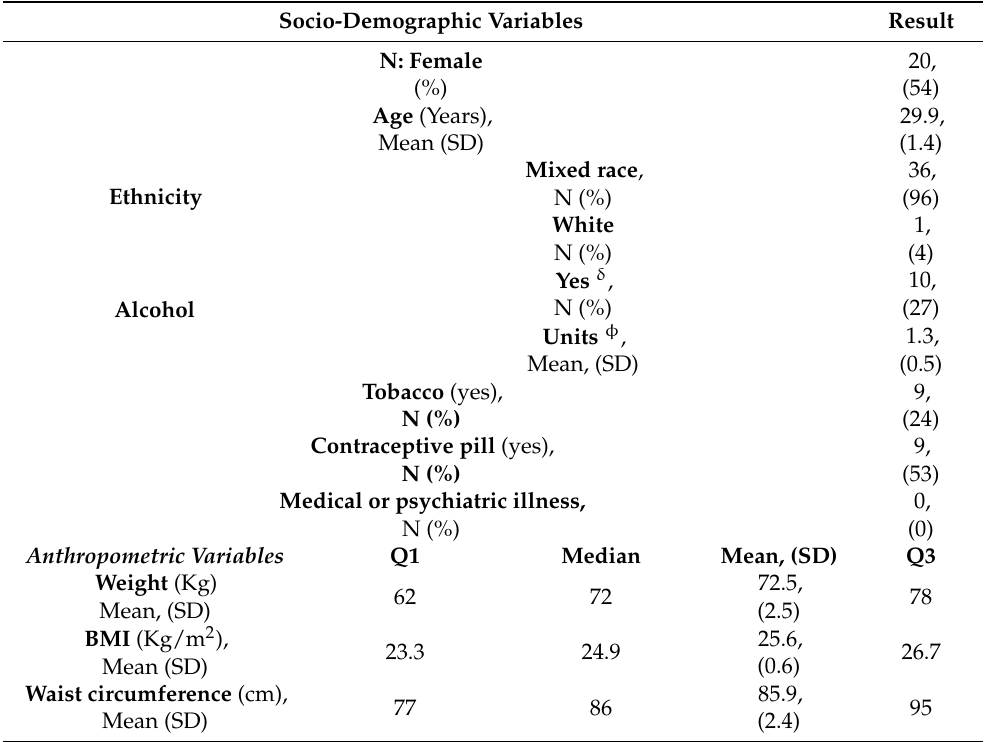
Table 1. Socio-demographic and Anthropometric Variables.